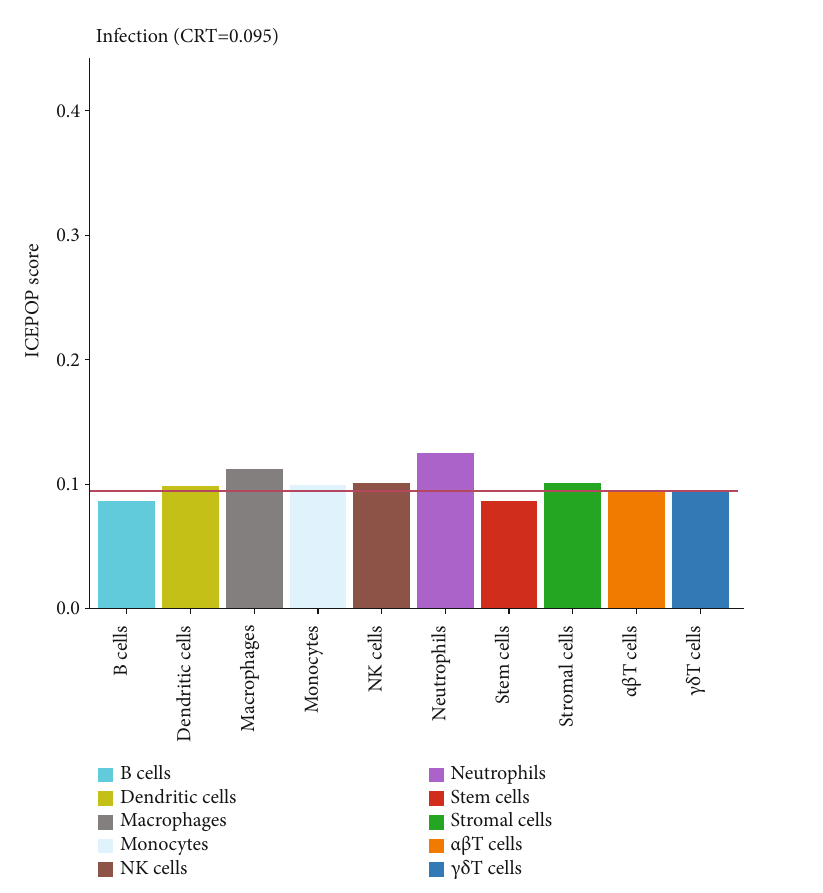
Figure 4: KEGG pathway classi fi cation of di ff erentially expressed genes induced by K. pneumoniae infection. KEGG terms of upregulated (a) and downregulated (b) genes in K. pneumoniae -infected lungs at 48 hours post infection.